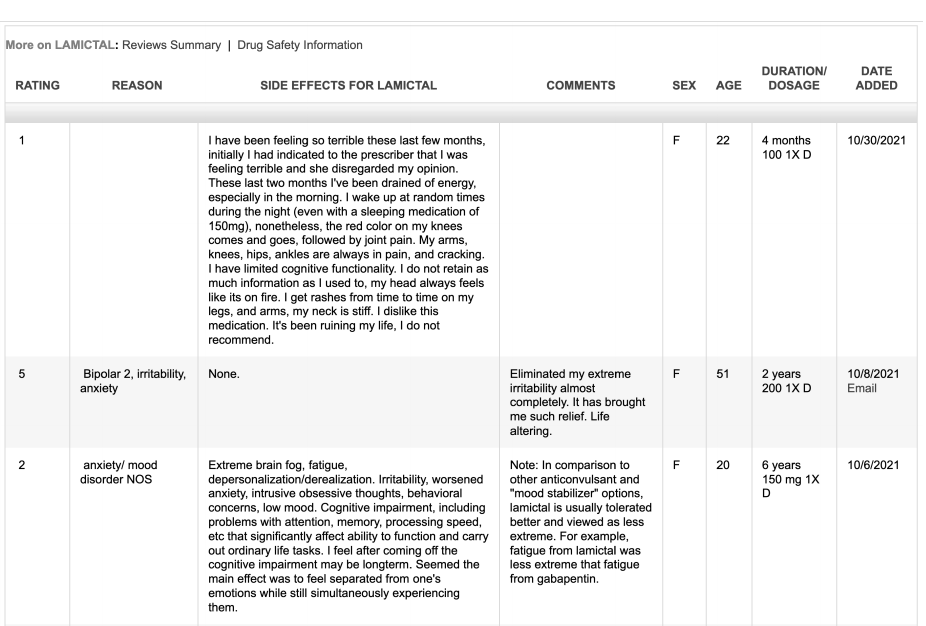
Figure 2. Snapshot of patients’ reviews extracted from Askapatient.com for Lamictal